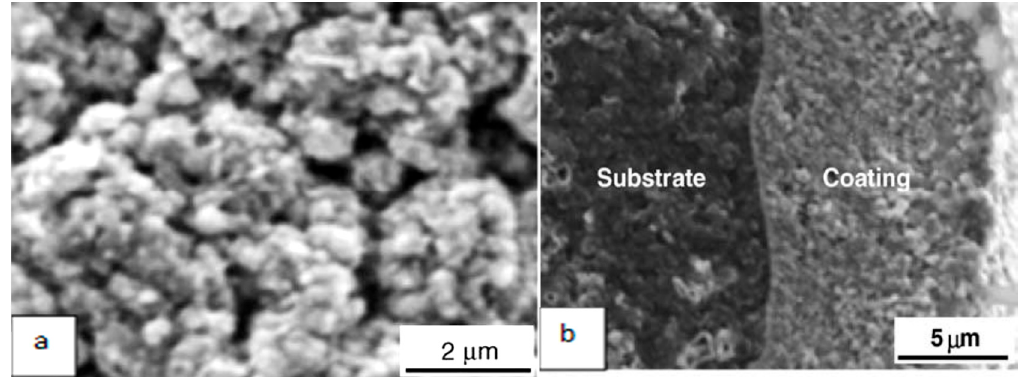
Figure 6. Titanium carbide coating: ( a ) powder; ( b ) cross sectional image (Yin et al., 2005).